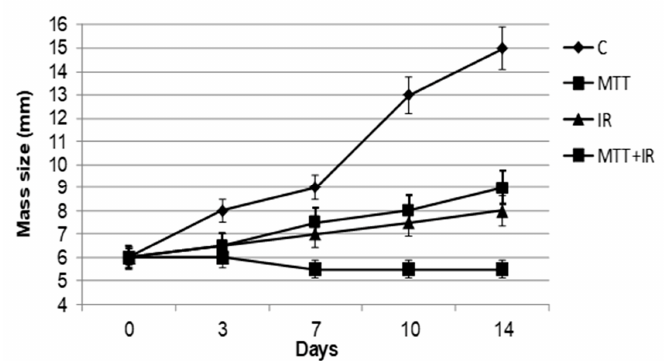
Figure 1. Effect of the different treatment regimens on adrenocortical carcinoma (ACC)-xenografted tumors. Tumor mass size reduction in mice receiving mitotane (MTT), ionizing radiation (IR), and MTT/IR. Both the MTT and IR treatments show a significant inhibition of neoplastic growth 7 days after the start of treatment ( p < 0.001). Mice receiving both treatments in combination (MTT/IR) show a lasting inhibitory effect throughout the treatment ( p < 0.0001).